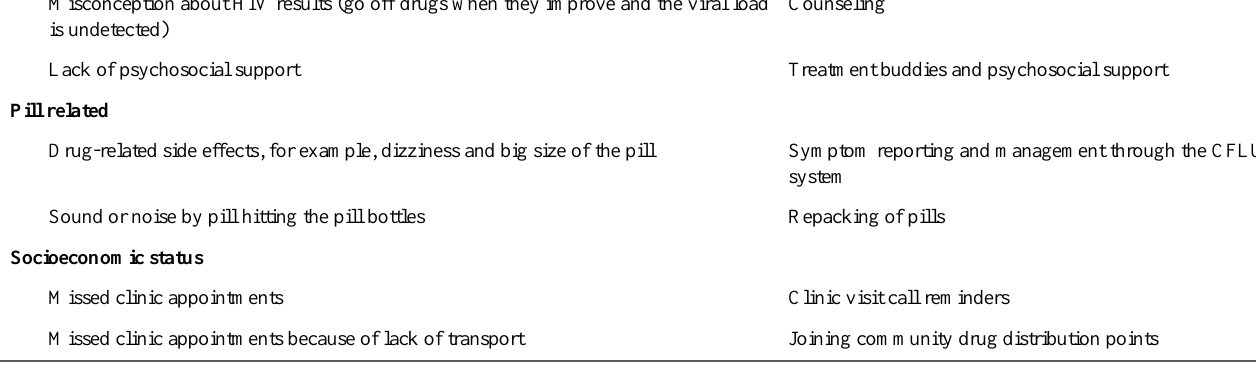
Strategies proposed through CFLUSubject and factors hindering ART a